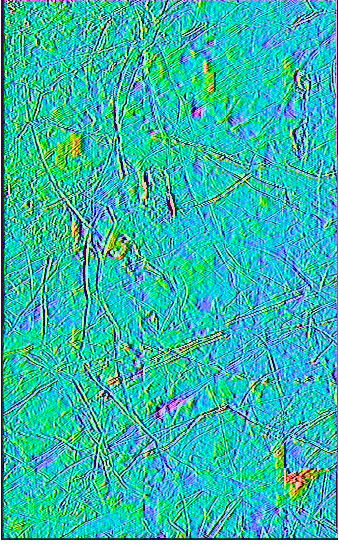
Figure 4. Difference between the DTM produced by stereonalysis of an “optimal” simulated image pair (80° incidence) and the “truth” DTM used in the simulations. Extent and color scale are as in Fig. 1d but the range of elevation differences is only 320 m, 1/10 as large as the full range of topography. The RMS difference is 36 m, corresponding to 0.17 pixel matching precision. Errors are not random, but highly correlated with topographic